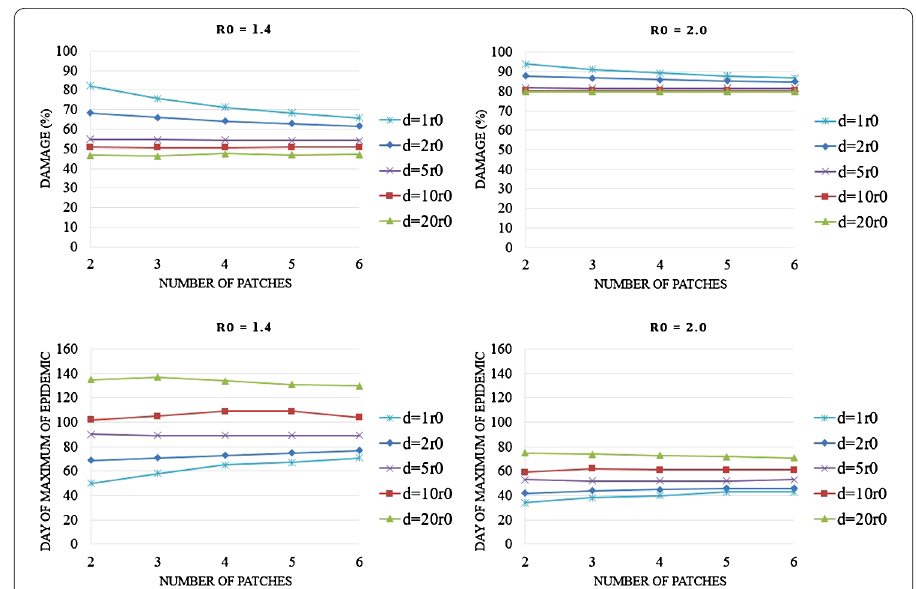
Figure 3 Relationships between the number of patches and the spatial range ( d ) with the percentage of loss.